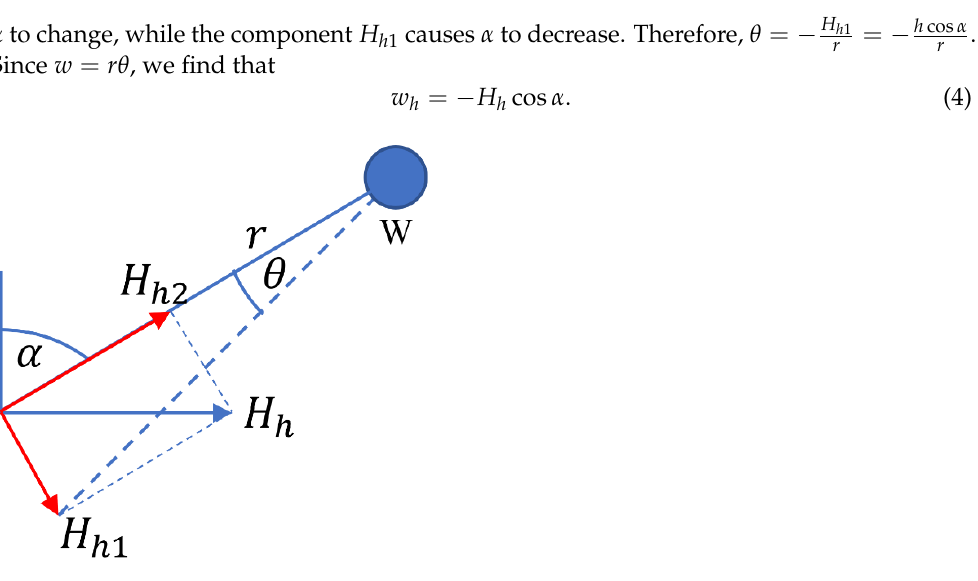
Figure 3. The W component seismometer in its plane of motion, with the ground moving sideward by a displacement of 𝐻 ℎ inside this plane.